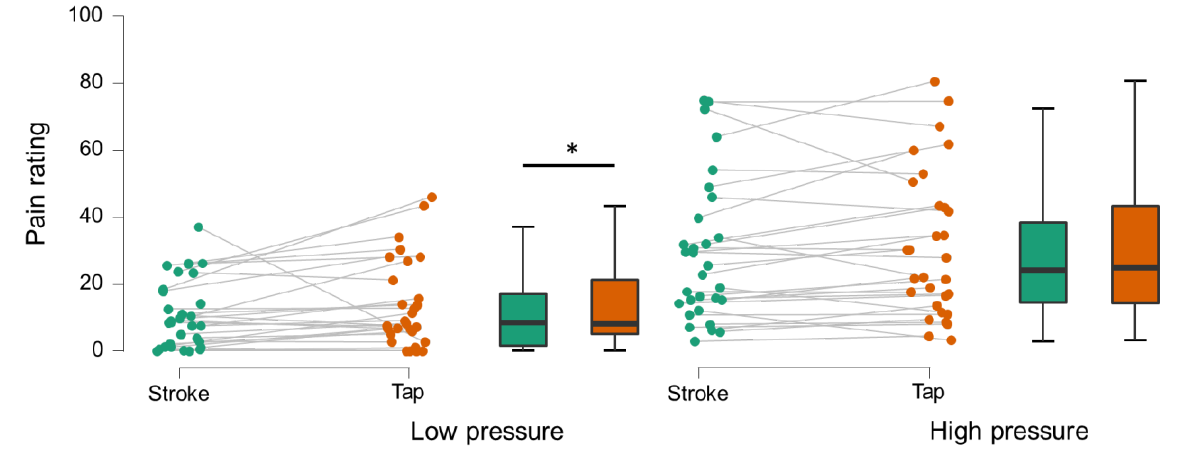
Figure 2. Pain ratings for low- and high-pressure trials. Dots display individual averages of ratings for low-pressure ( left ) and high-pressure ( right ) trials. Stroking (green) reduced pain ratings of low-pressure trials significantly (Z = − 2.76, p = 0.006) compared to tapping (orange). Boxplots display median (center bar), first–third quartile (box), and 1.5 IQR (whiskers); * indicates significant difference.